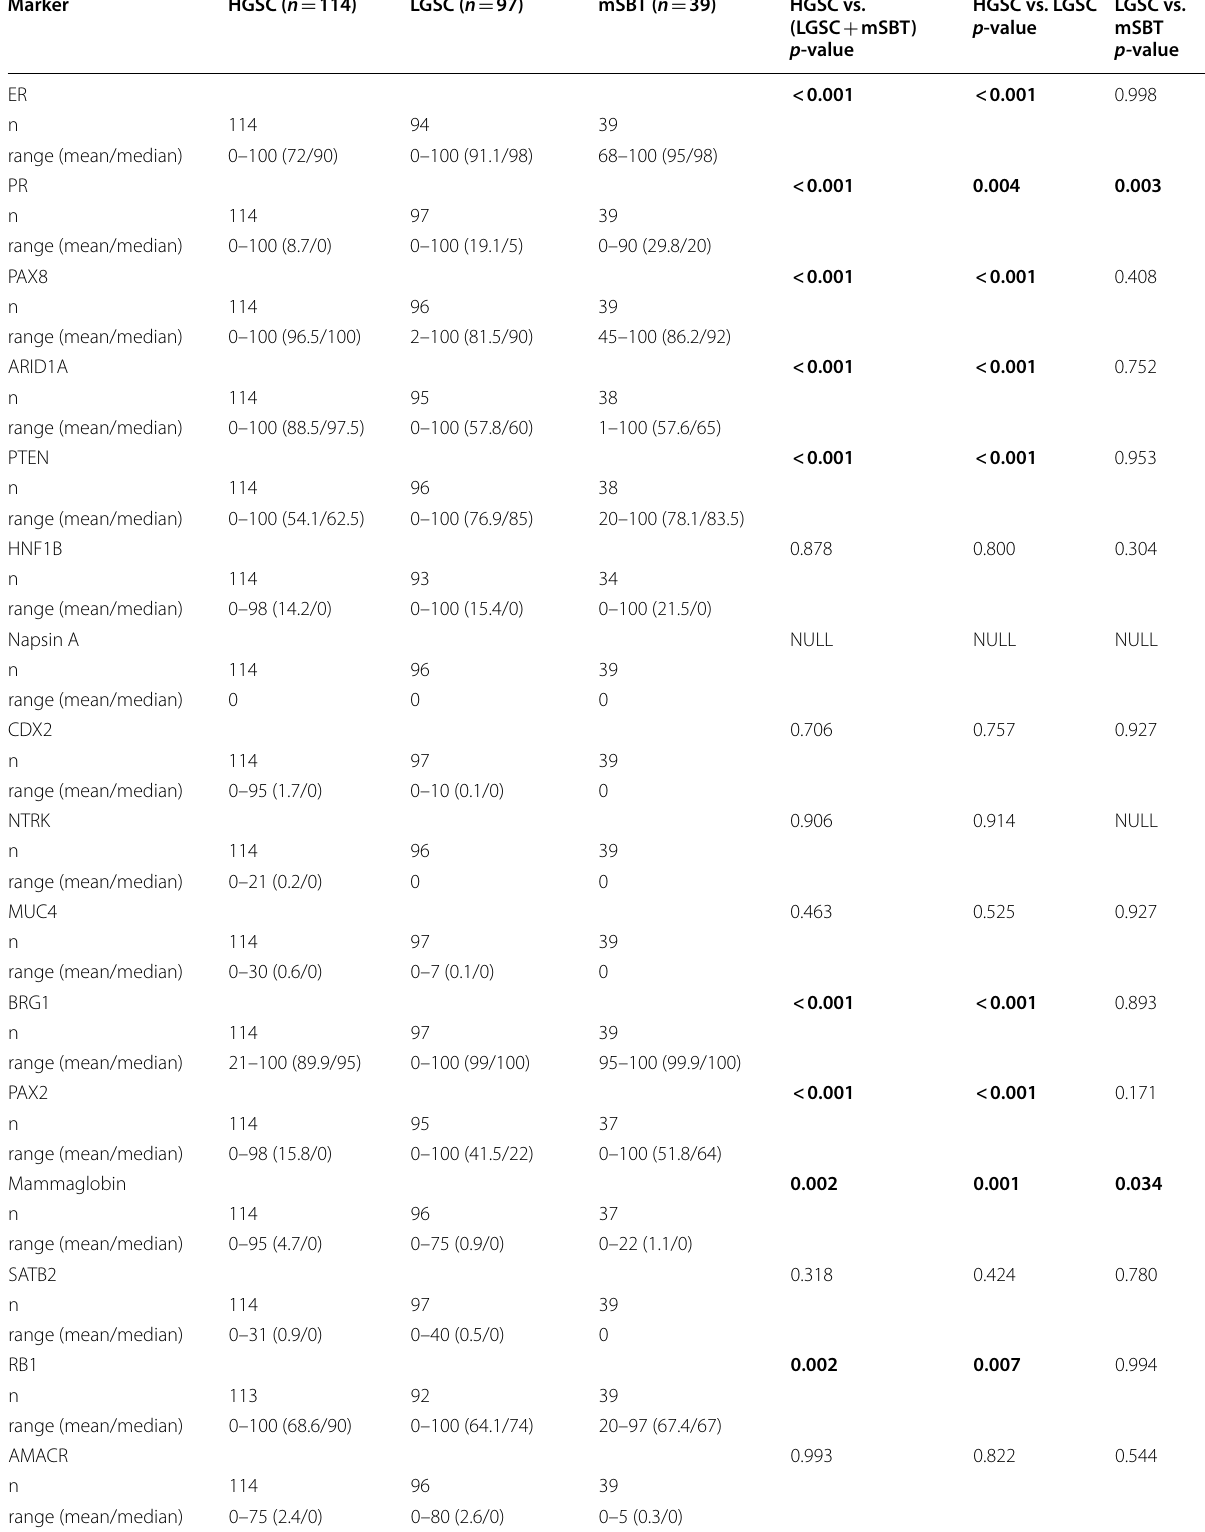
Table 2 Overview of overall positivity (%) of 26 markers and differences between tumor